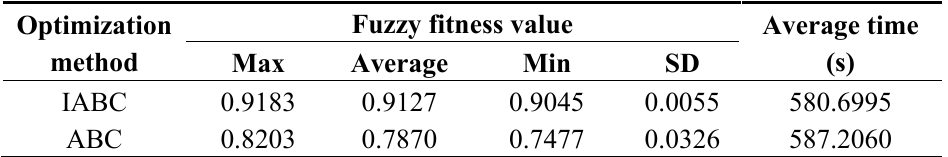
Table 11. Results obtained by the different algorithms for fuzzy multi-objective OPF for the IEEE 300-bus